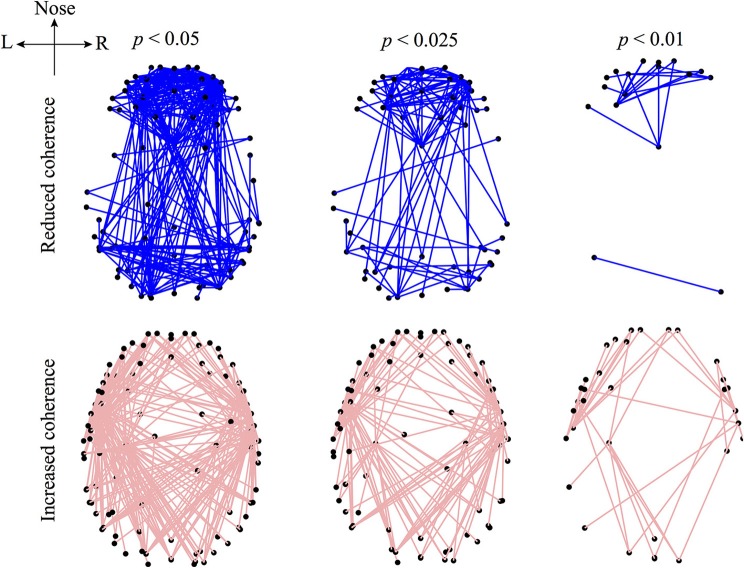
Graphical representations of the electrode pairs with significantly reduced (upper panel) or increased (lower panel) phase-coherence of the sub-delta band (0.05–1.5 Hz) EEG induced by propofol anesthesia. EEG data (128-channel recording) were recorded from 5 subjects and processed by the EEG_coherence algorithm diagrammed in Figure 3. The electrode pairs with significant (p < 0.05) changes in phase coherence are connected with lines. The electrode-pair map is represented in a bird's-eye view of the 3D head model (created via the modified EEGLAB function plotchans3d). The black dots are EEG_coherence selected electrodes. Electrode pairs for altered phase coherence are determined with different levels of significance (significance-level p was set at 0.05, 0.025, and 0.01 in the Mann-Whitney U-test). Smaller p thresholds result in a lower density of electrode-pair cluster due to the stricter selection criterion, however, the electrode-pair distributions are generally preserved in trend.